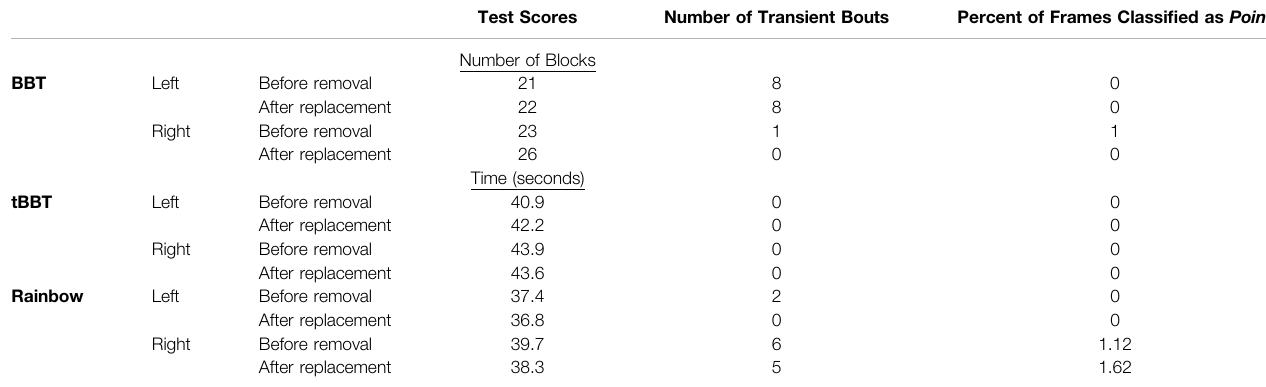
TABLE 3 | Functional outcome measures achieved during simulated donning/dof fi ng. Testing with both arms was completed using a classi fi er trained with a continuous dynamic strategy under the load B condition (BBT = Box and Blocks Test; tBBT = Targeted Box and Blocks Test). Test Scores Number of Transient Bouts Percent of Frames Classi fi ed as Point Number of Blocks